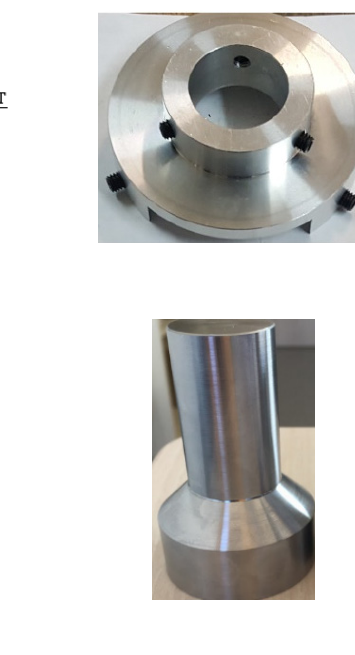
Figure 1. Principal of the Quasi-Oedometric Compression test: ( a ) Developed by Burlion et al. [24] instrumented with LVDT; ( b ) Developed by Forquin et al. [25], instrumented with strain gauges and an extensometer.